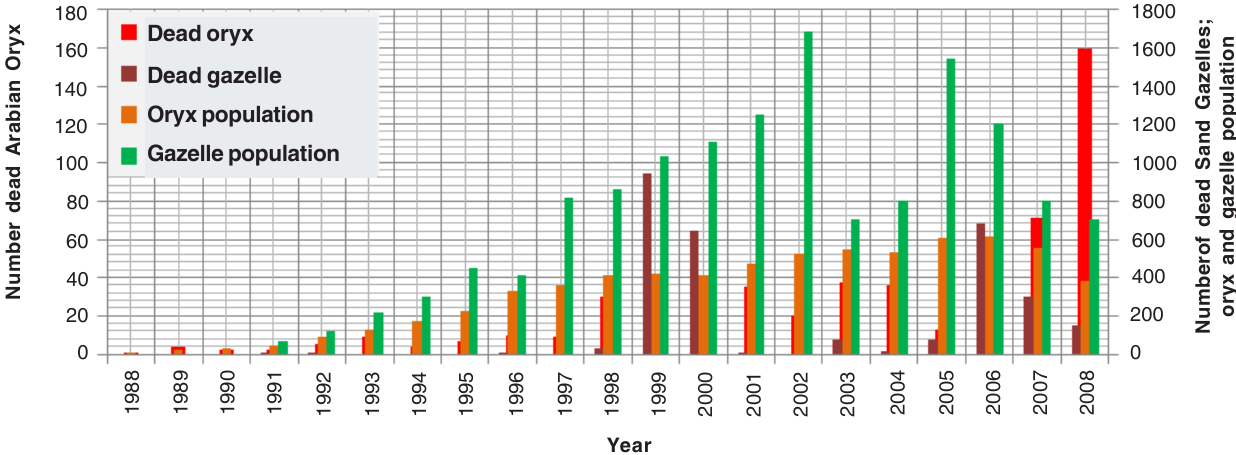
Figure 1. Mortalities and populations of Arabian Oryx and Sand Gazelle in Mahazat as-Sayd Protected Area, Saudi Arabia, 1988-2008.